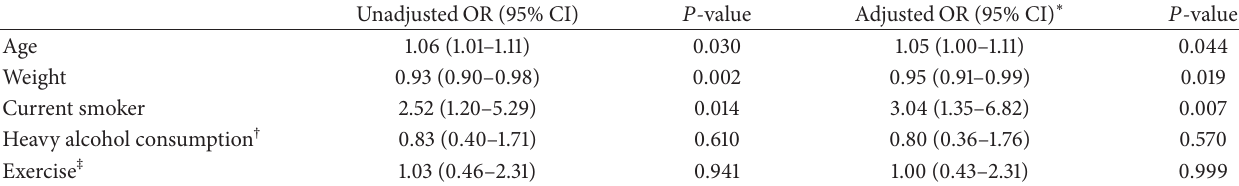
Table 3: Results of logistic regression: crude and multivariate-adjusted OR of osteoporosis for risk factors in men under 70 years of age.